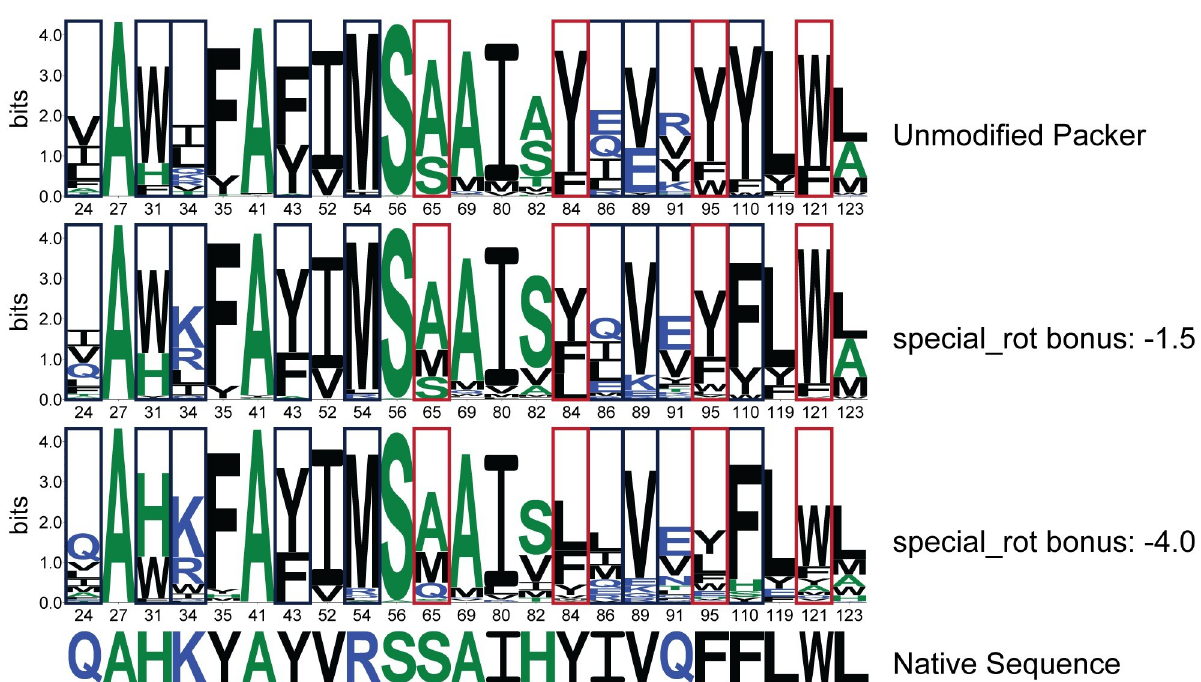
Fig 5. Sequence Logos for Recovery of Designable Binding Site Positions. Binding site recovery is shown for the engineered lipocalin DigA16 in complex with digitoxigenin (PDB ID: 1LNM, Ligand chemical component identifier: DTX). Sequence logos depict positional information content in bits, where residue identities are colored based on hydrophobicity (hydrophilic, blue; neutral, green; hydrophobic, black). Designable positions are in Rosetta numbering as in S4 Table. Design positions in navy blue boxes show improved native sequence recovery with the application of complementary rotamers. Specifically, positions with polar or charged residues show increased recovery with increased magnitude in the special_rot bonus. While the native residue identity of position 91 is not found, an isosteric residue is recovered with the application of complementary rotamers. Sequence recovery for positions in red boxes is negatively affected with increased special_rot bonus when compared to the unmodified Packer.